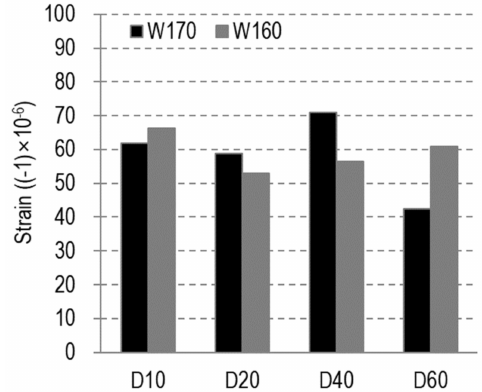
Figure 10. Drying shrinkage strain at cracking.